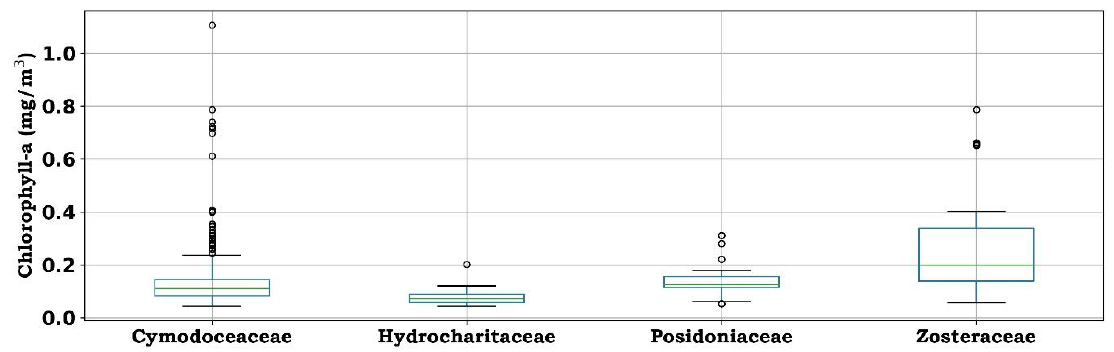
Figure 8. Boxplots of chlorophyll-a concentration [mg / m 3 ] at the locations in which seagrass families are present in the Mediterranean Sea (inner line represents sample median, box boundaries represent the distance between first and third quartile, error bars represent the 95% CI for the median, and open circles represent the outliers).